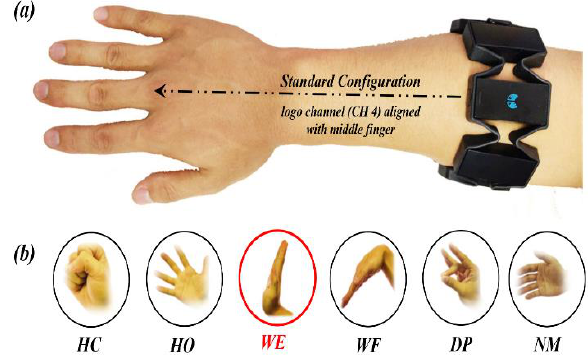
Figure 2. Scheme of standard electrode configuration and applied hand gestures. ( a ) Logo channel, also defined as CH 4 is suggested to be aligned with middle finger. ( b ) Red-marked synchronous gesture, WE is used to identify electrode shift. Here hand closed (HC), hand opened (HO), wrist extension (WE), wrist flexion (WF), double tap (DT) and no movement (NM).